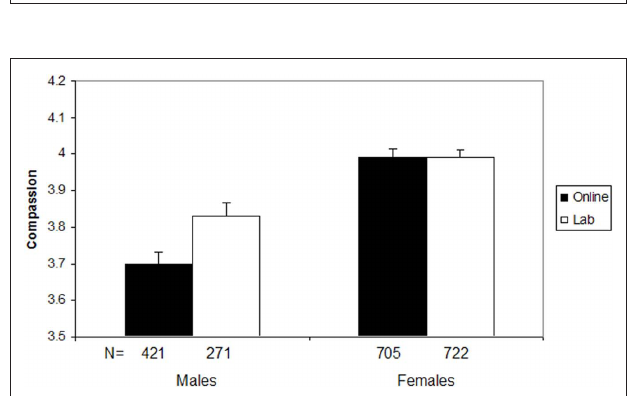
FIguRE 8 | Age moderates gender differences in Orderliness (residualized). Residualized scores are depicted as the scores plus 1, for ease of interpretation.